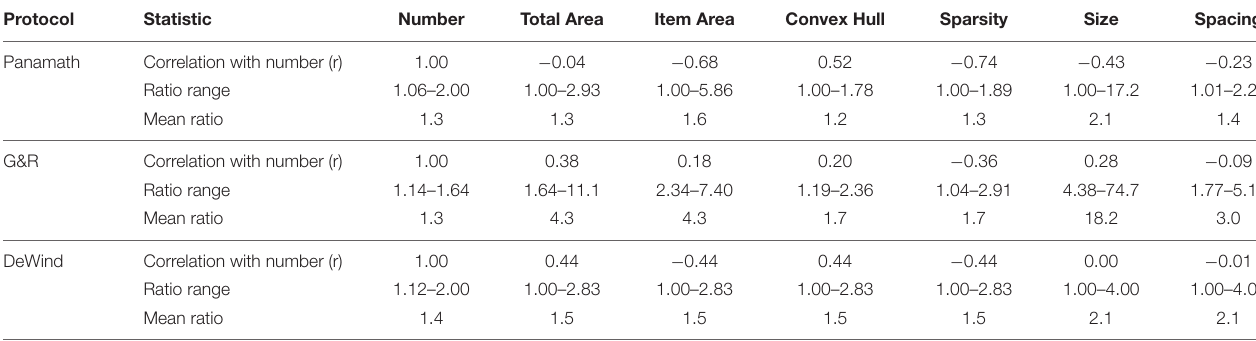
TABLE 1 | Comparison of stimulus feature ratio